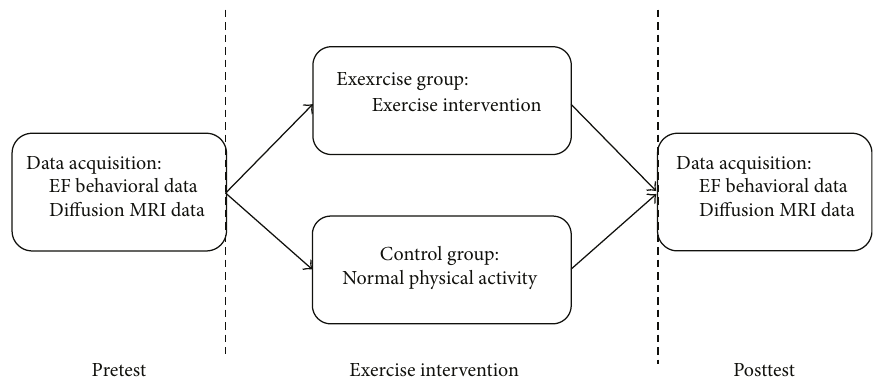
Figure 1: Experimental